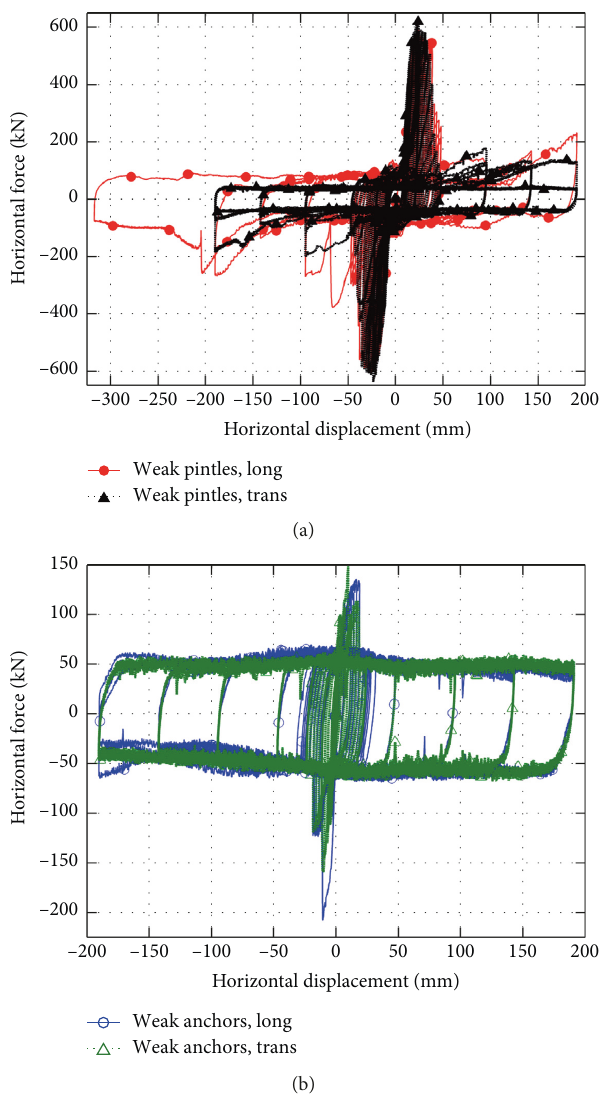
Figure 1: Results of complete weak (a) pintle and (b) anchor